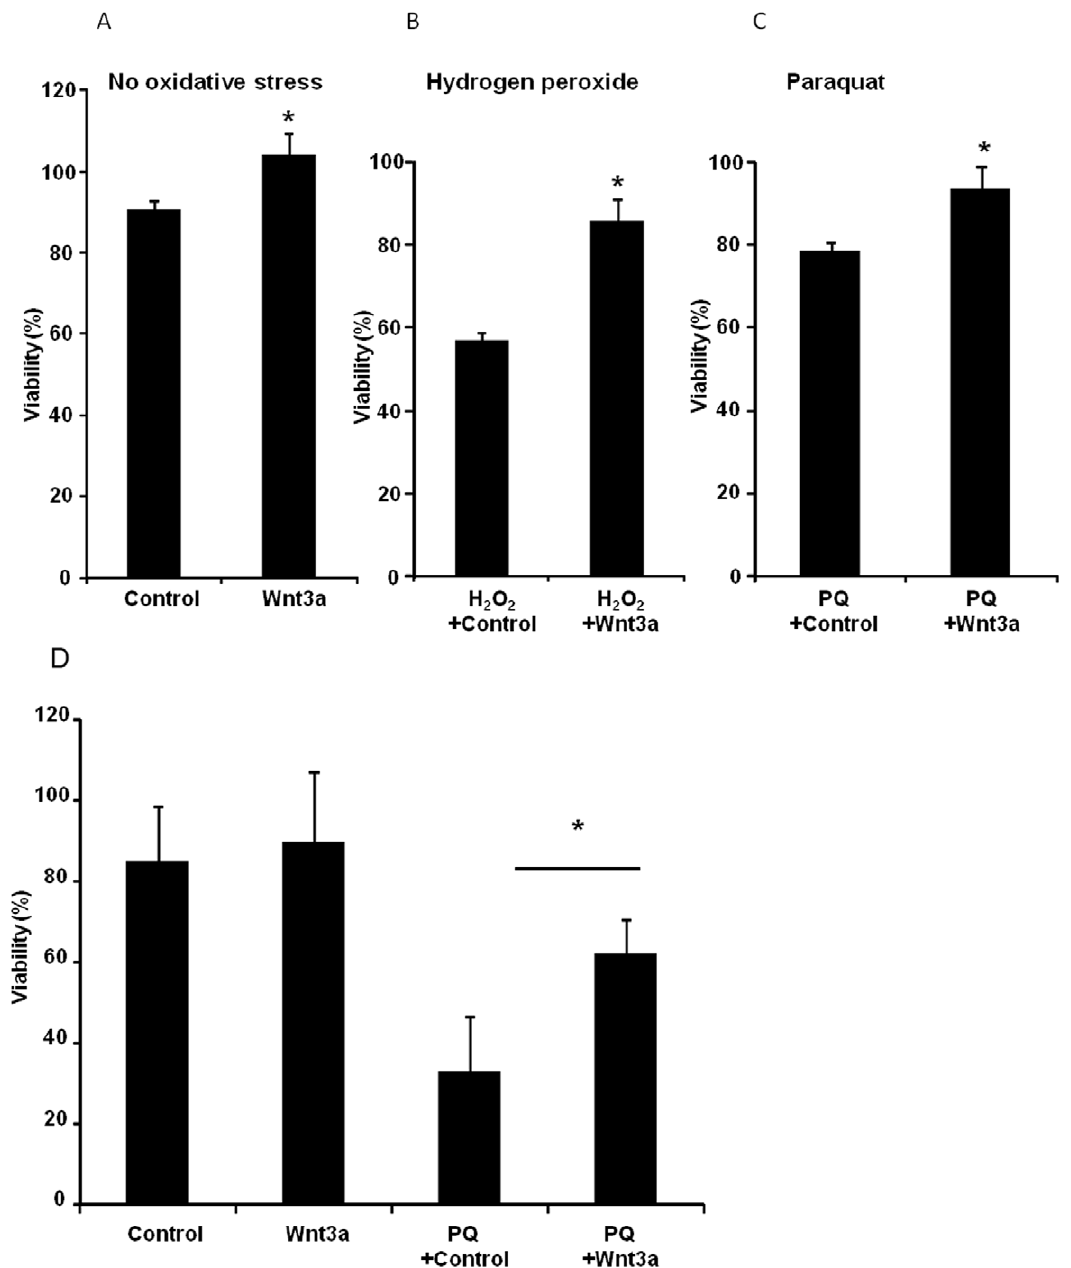
Figure 2. Activation of the Wnt pathway protected ARPE-19 cells from oxidative stress. Cellular viability was significantly increased in the presence of Wnt3a conditioned media compared with control conditioned media when oxidative stress is induced with either 0.4 mM hydrogen peroxide (H 2 O 2 ) (n=4, *p , 0.05) (B) or 0.4 mM paraquat (PQ) (n=9, *p , 0.05) (C), both for 24 hr. The viability of uninjured cells was also modestly increased by Wnt3a (n=9, *p , 0.05) (A). Cell viability was also significantly increased by Wnt3a when cells were cultured as polarized post-confluent monolayers on permeable membranes in the presence of 1.6 mM paraquat (n=3, *p , 0.05) (D). Viability was measured by Cell Titer Blue assay.